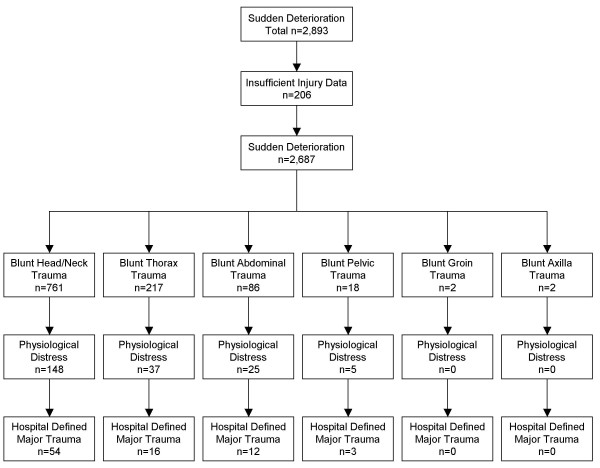
Sudden Deterioration, Blunt Trauma, Physiologically Distress and Hospital Defined Major Trauma.